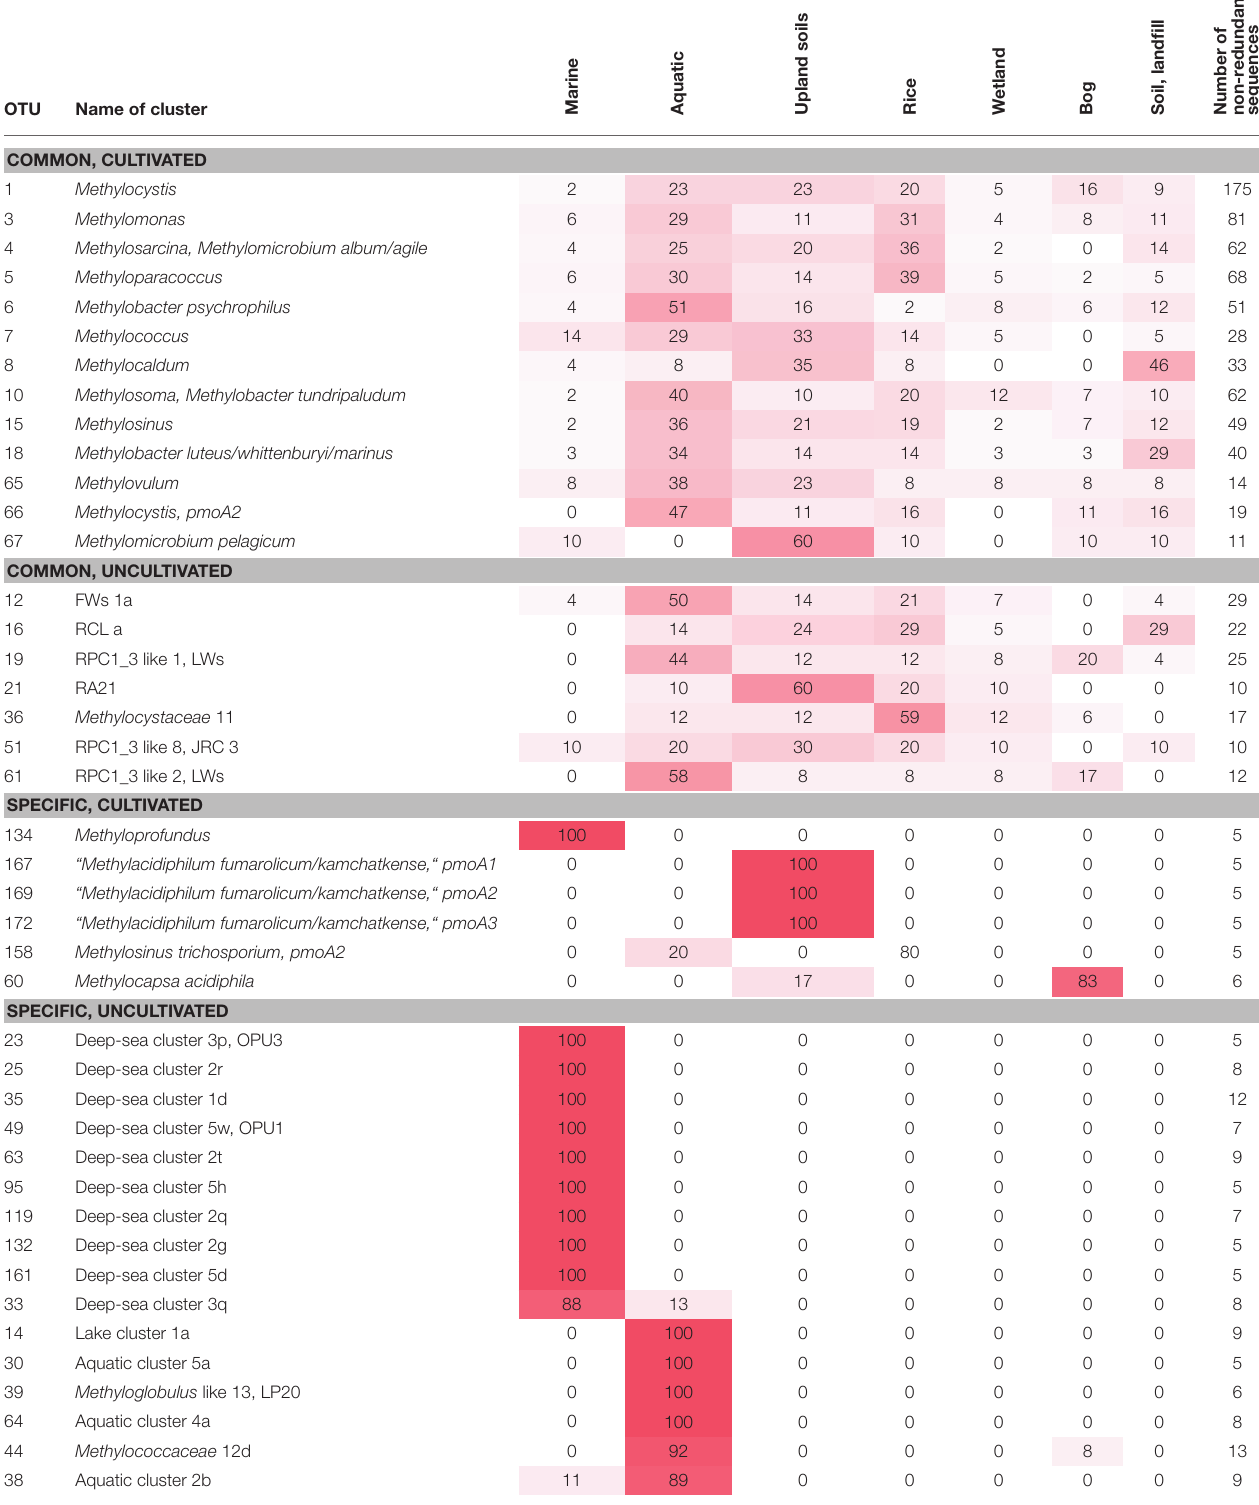
TABLE 8 | Broadly distributed and habitat-specific OTUs 12